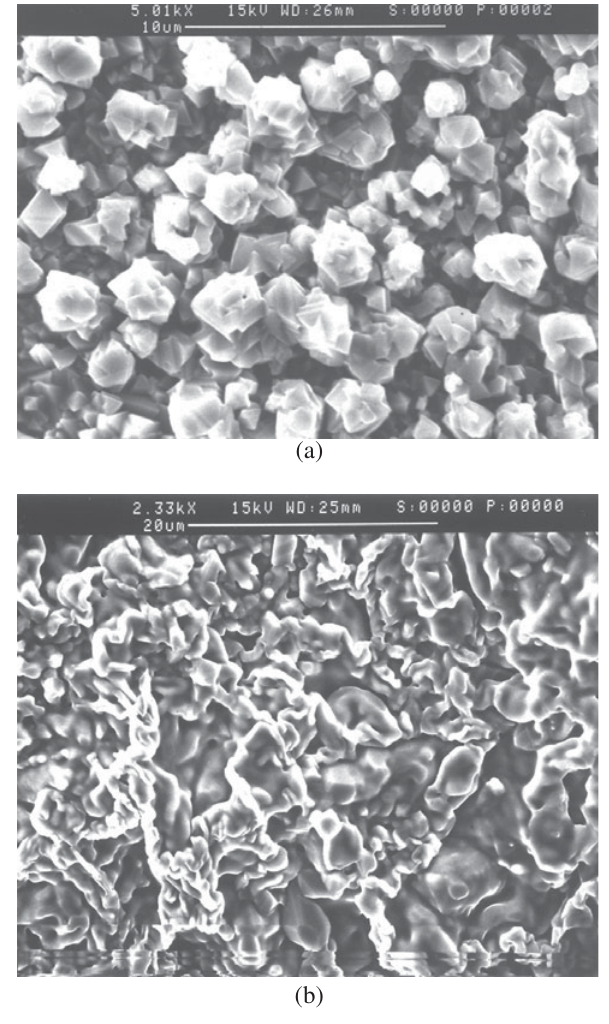
Figure 9. Observation of the surface of the 304 steel oxidized in oxygen at 950 °C: a) bottom of a spalled zone: chromium oxide; b) unspalled surface, iron